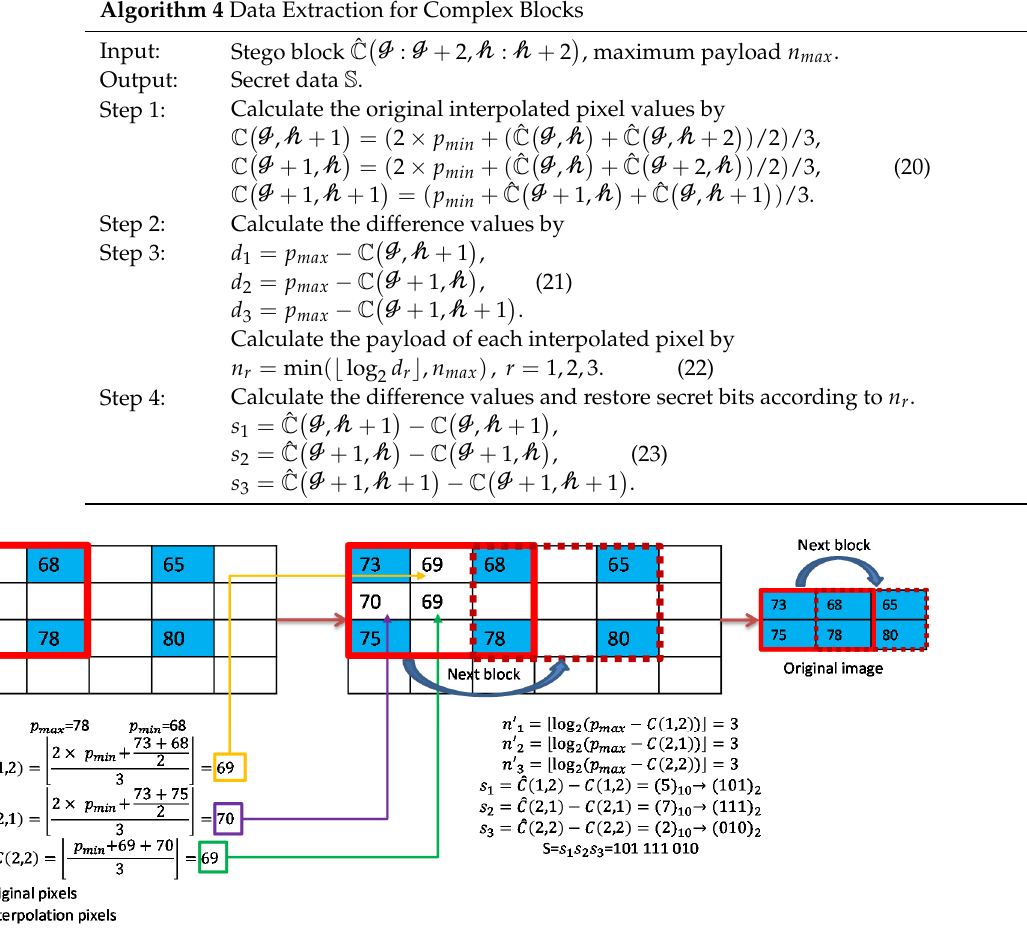
Figure 6. Example of interpolation and data embedding for complex blocks.